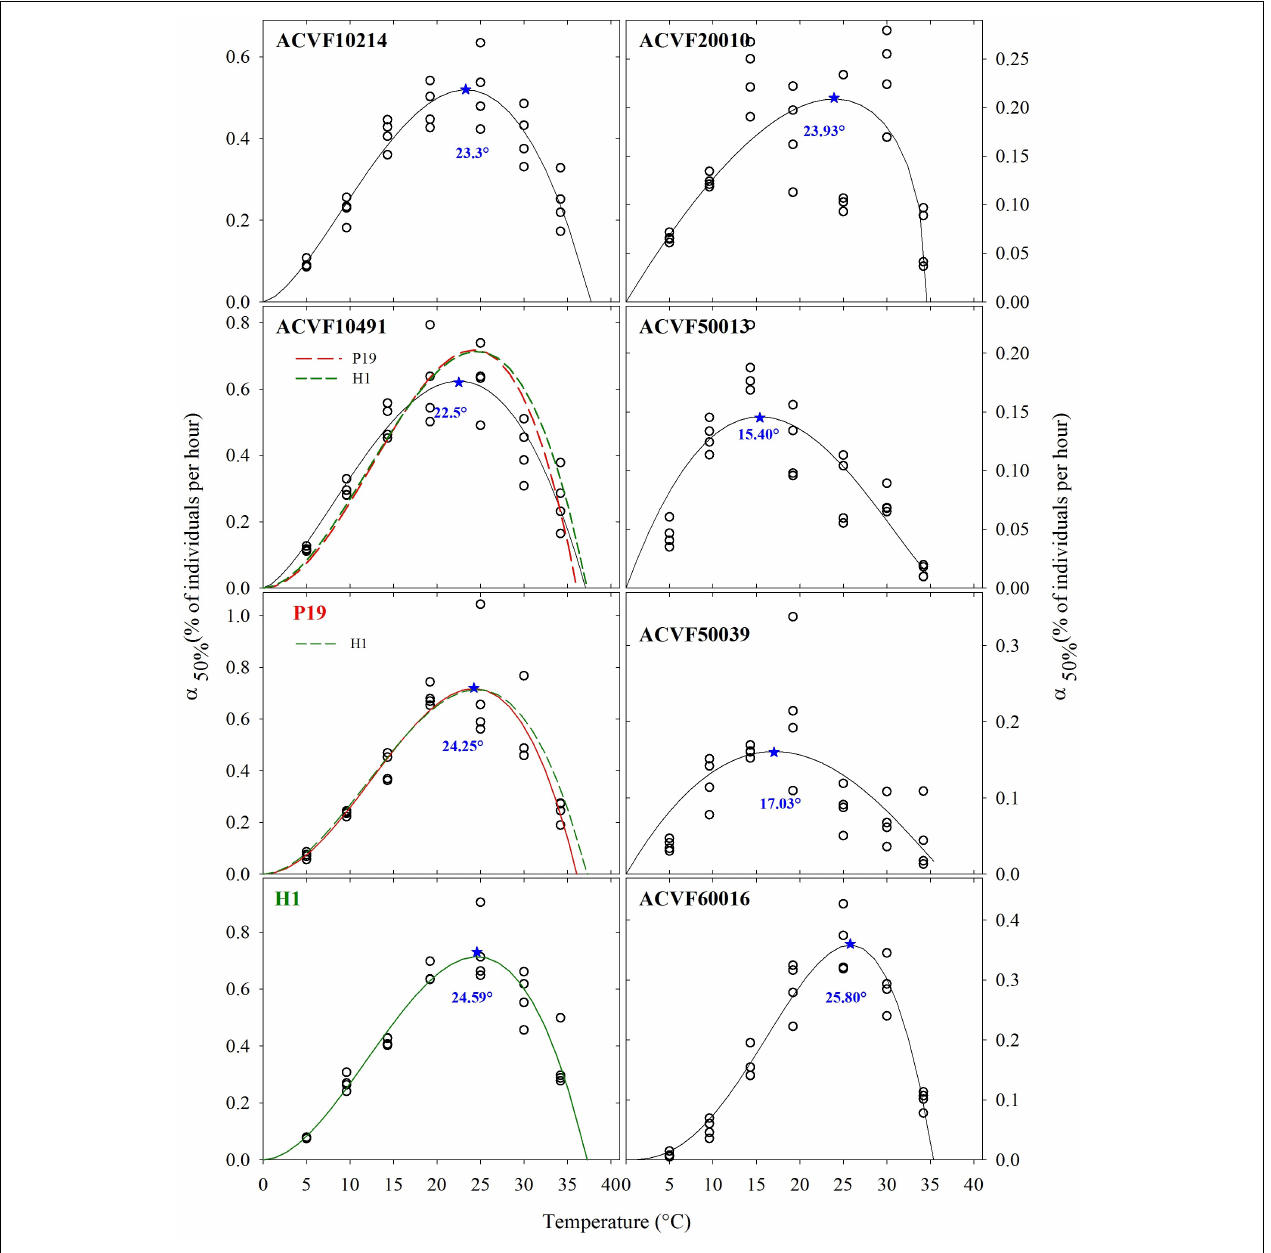
FIGURE 3 | Estimated germination rates, when 50% of the seeds have germinated ( α 50% ), fitted with the beta model, for eight accessions of Lolium perenne in response to a constant temperature *indicates the estimated optimal